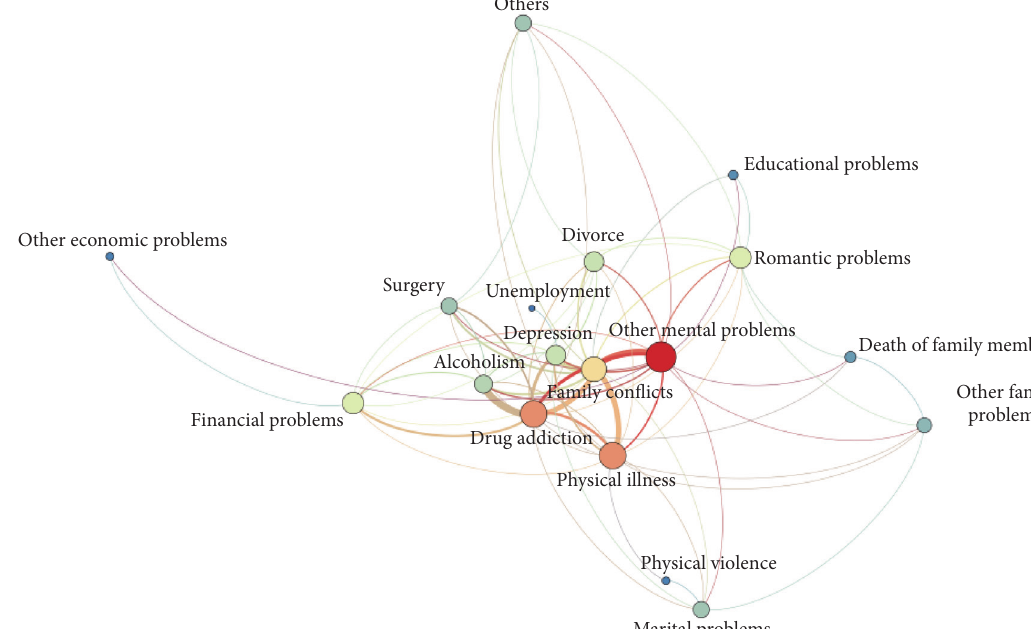
Figure 1: Network of issues preceding the deliberate self-poisoning.